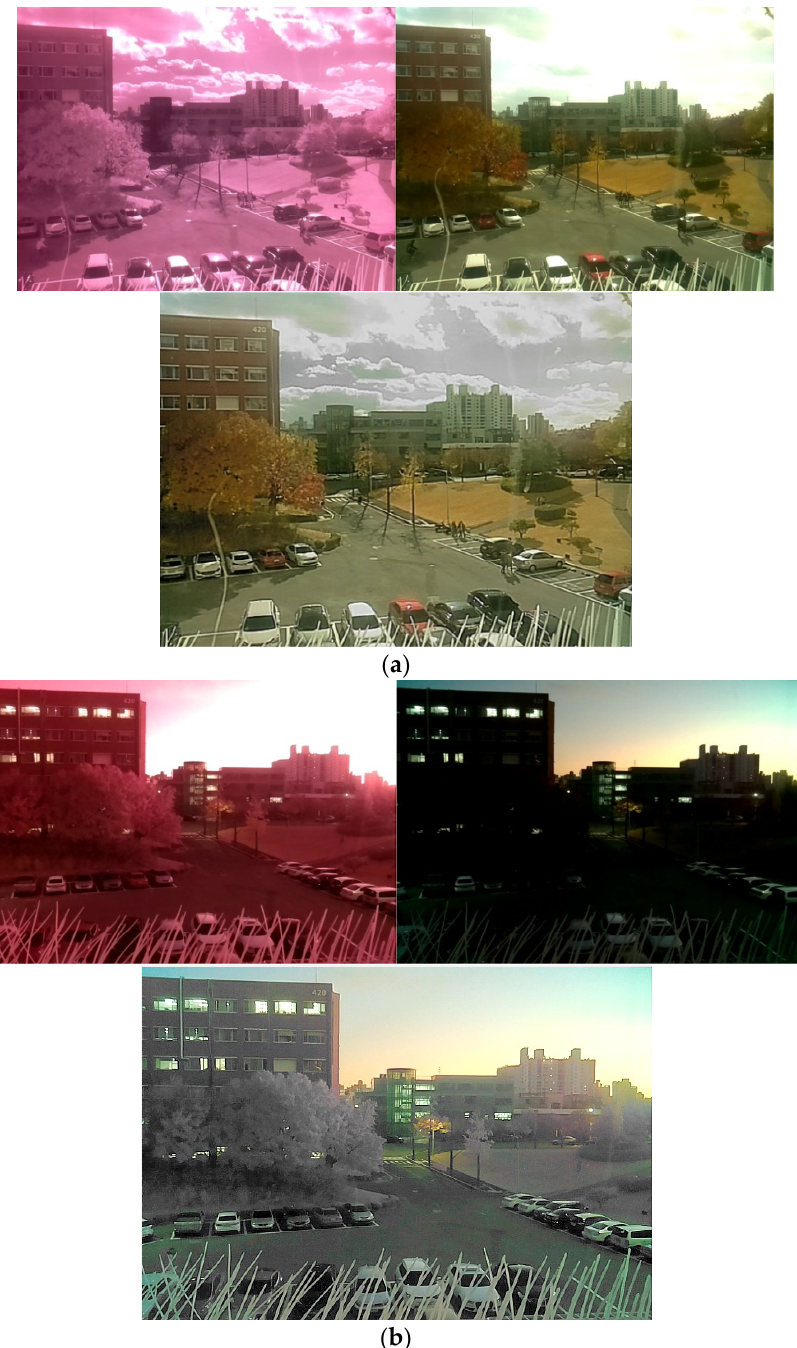
Figure 6. NIR, visible, and fused images: ( a ) bright surround input and fused images and ( b ) dim surround input and fused images.